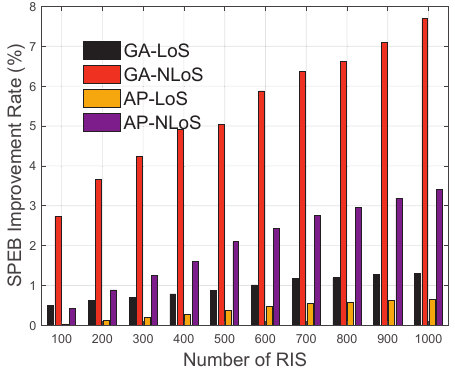
Figure 5. SPEB with different numbers of RIS in NLOS.